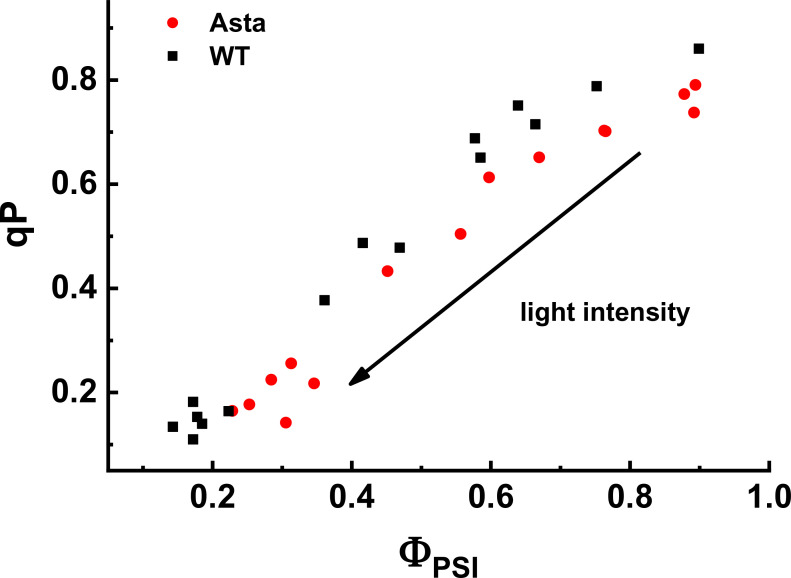
Relation between photochemical quenching (qP) and ΦPSI measured at various light intensities (70–1030 μmol photons m−2 s−1).